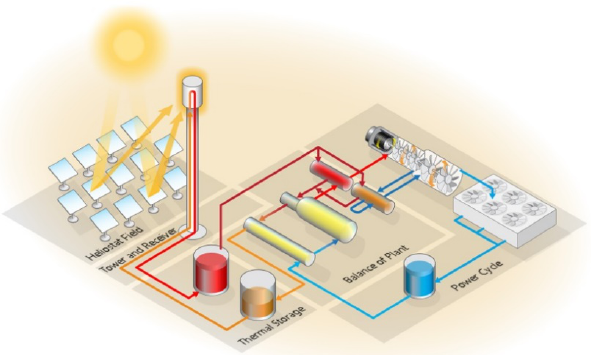
Figure A1. Schematic of the simulated Gemasolar thermosolar power plant in the SAM. The different components of a central receiver system are depicted. ( © System Advisor Model Version 2017.9.5, SAM